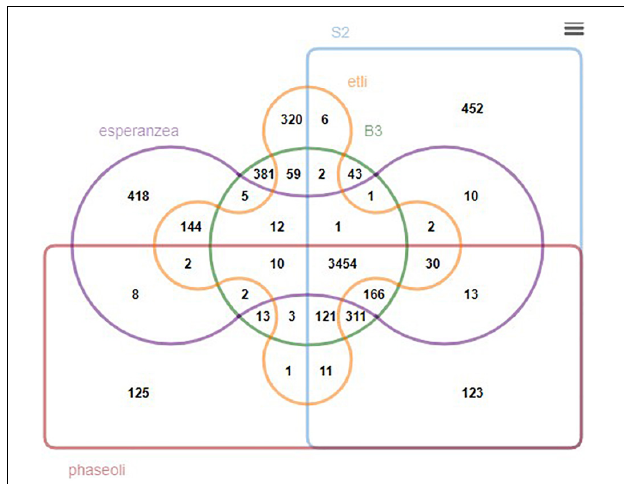
FIGURE 6 | A Venn diagram showing the overlapping orthologous genes between isolates B3, S2, and three other reference rhizobia species. TABLE 3 | ANI, AAI, dDDH, and genetic distances between isolates B3, S2, and R. phaseoli . Query genome Reference genome